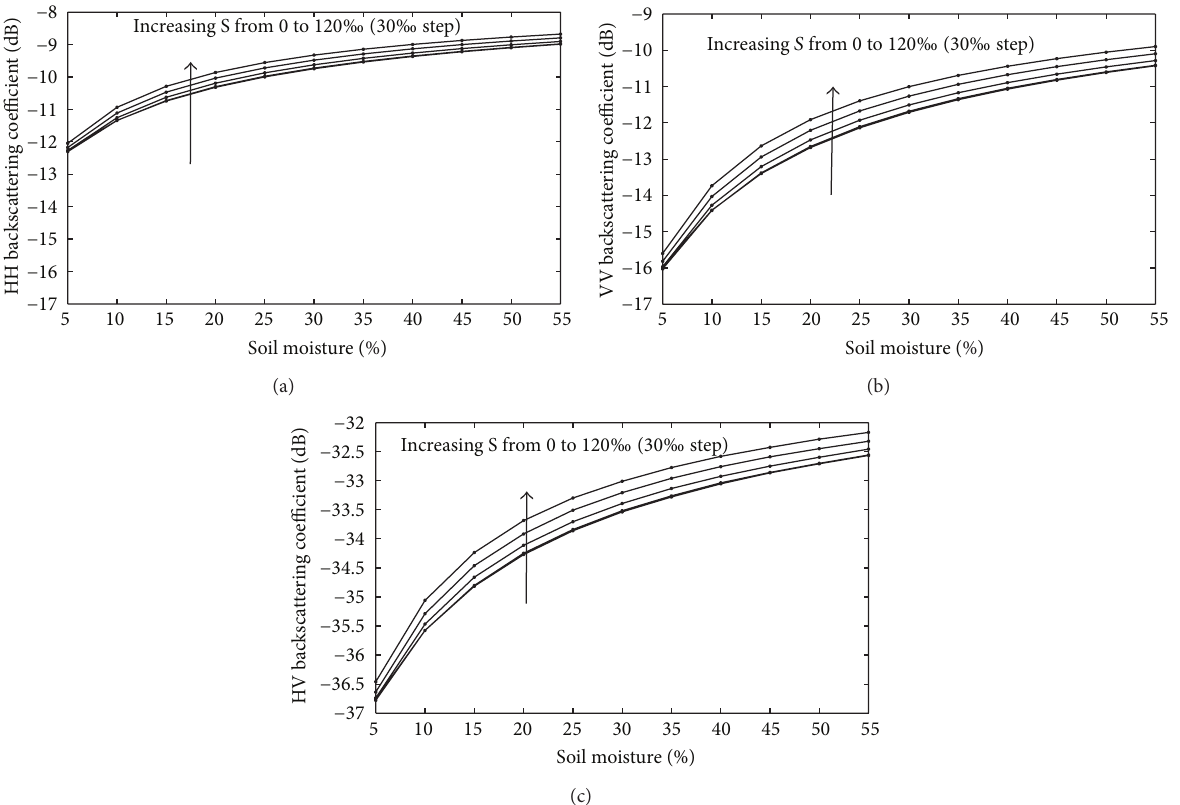
Figure 8: AIEM simulations of the simulated dielectric constant for the backscattering coefficient at a C band of 40 ∘ incidence angle with a variation in soil moisture and soil salinity. (a) HH polarization, (b) VV polarization, and (c) HV polarization.